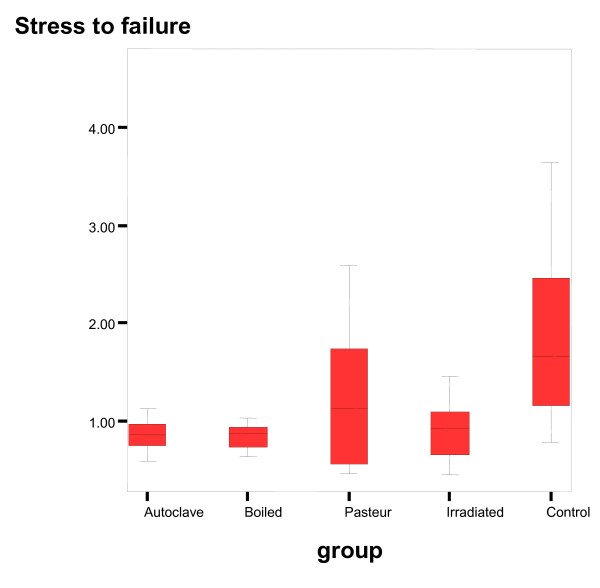
shows the calculated material properties Stress to failure. Material properties (mean, +/- standard error) of the bone samples, stress to failure for the four different treatment groups and the control group. Post-hoc Tukey tests found that autoclaving and boiling; to a less extent gamma irradiation significantly reduced the material properties (p < 0.05).